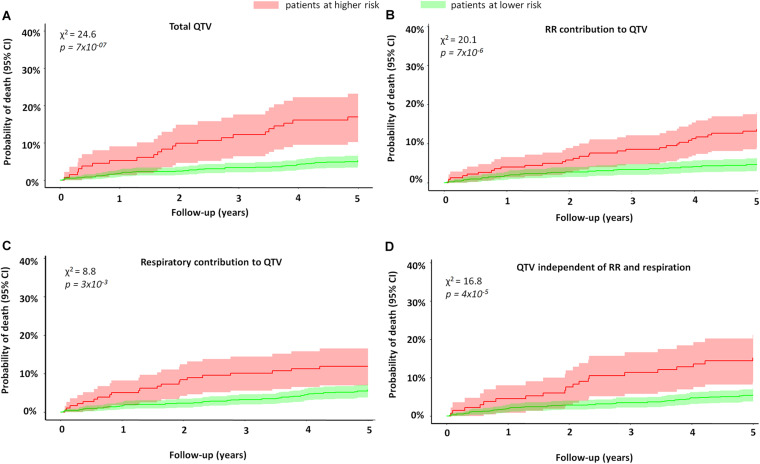
Mortality of MI patients stratified by QTV and its components. The figure shows the Kaplan–Meier curves of MI patients stratified by (A) total QT variability, (B) percentage of RR contribution to QTV, (C) percentage of respiratory contribution to QTV, and (D) percentage of QTV independent of RR and respiration. The red curve represents patients at higher risk, while the green curve represents those with lower risk. Patients with higher QTV had a higher risk of mortality compared to those with lower QTV (16.8% vs. 5.5%, p < 0.001). Patients with higher QTV independent of RR and respiration also had a higher 5-year mortality rate (15.2% vs. 5.5%, p < 0.001). Finally, the 5-year mortality rate was higher for patients with reduced RR and respiratory contributions to QTV (13.5% vs. 4.8%; 11% vs. 5.7%, respectively). The figure demonstrates the univariate predictive value of QTV and its components is risk stratification.